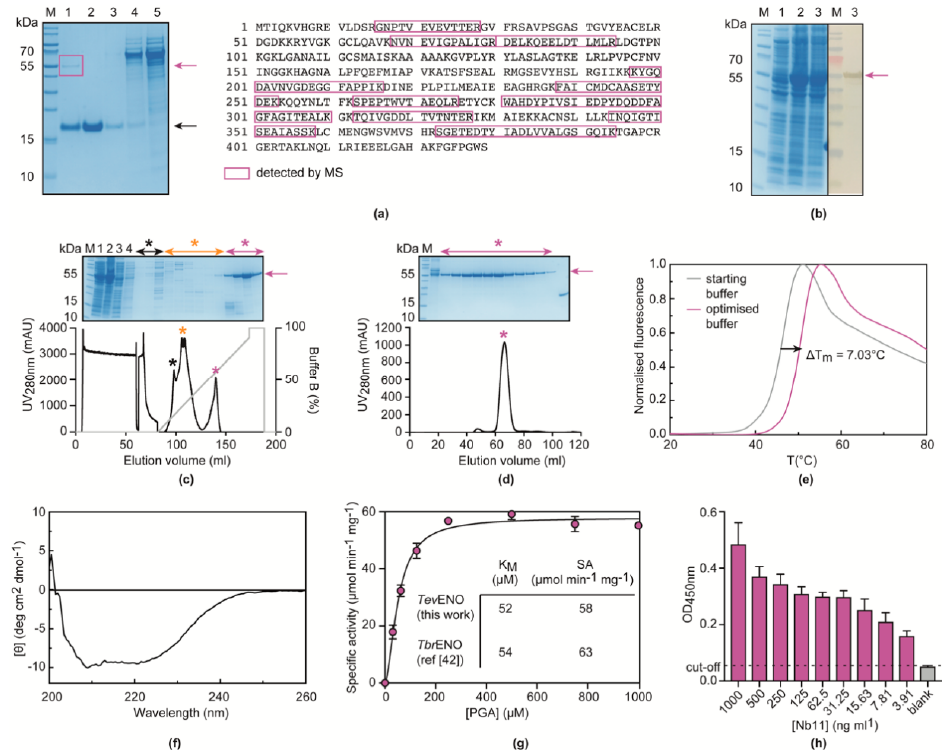
Figure 3. Nb11-mediated identification of T. evansi enolase ( Tev ENO) as the target antigen. ( a ) Nb11- mediated immunocapturing experiment and MS analysis. T. evansi secretome was allowed to interact with nickel beads loaded with His-tagged Nb11. After a washing step, the captured protein was eluted, and all fractions were analyzed on a 12% SDS-PAGE developed with Coomassie blue stain. Lane M, PageRuler Prestained Protein Ladder; Lane 1, eluted fraction; Lane 2, Nb11; Lane 3, wash fraction; Lane 4, secretome flow through; Lane 5, T. evansi secretome (starting material). Native Tev ENO and Nb11 migrate at ≈ 55 and ≈ 15 kDa and are indicated by purple and black arrows, respectively. The boxed gel band was excised and sent for mass spectrometry (MS) analysis, which detected several peptides (highlighted by purple boxes) covering up to 39.86% of the entire Tev ENO sequence. ( b ) Recombinant production of Tev ENO in Escherichia coli . Samples of the bacterial culture were taken before induction (Lane 1), 4 h after induction (Lane 2), and 16 h after induction (Lane 3) and analyzed by SDS-PAGE (left) and Western blot (right). The band corresponding to His-tagged Tev ENO is indicated by the purple arrow. Lane M, PageRuler Prestained Protein Ladder. ( c , d ) Purification of recombinantly produced Tev ENO via immobilized ion metal affinity chromatography (IMAC) ( c ) and size exclusion chromatography (SEC) ( d ). The insets represent SDS-PAGE analyses of the purification procedure. Lane M, PageRuler Prestained Protein Ladder; Lane 1, supernatant of the bacterial culture after sonication; Lane 2, pellet after sonication; Lane 3, IMAC flow through; Lane 4, IMAC wash; Lanes ‘*’, various fractions collected during IMAC elution and SEC. ( e ) Results of the TSA conducted with Tev ENO in an effort to improve its stability during purification. The grey and purple traces represent the Tev ENO melting curves in the starting (50 mM Tris, 200 mM KCl, 5 mM MgCl 2 , pH 8.0) and optimized (50 mM sodium phosphate, 5 mM MgCl 2 , pH 7.0) buffers, respectively. ( f ) CD spectrum of Tev ENO, collected in the optimized purification buffer, shows that the recombinantly obtained enzyme is properly folded. ( g ) Enzymatic activity of recombinantly produced Tev ENO towards different concentration of its substrate 2-phosphoglycerate (2-PGA). The inset shows a comparison of the kinetic parameters obtained for Tev ENO in this work and those determined for Tbr ENO by Hannaert and co-workers [44]. ( h ) Titration curve of Nb11 on Tev ENO via indirect ELISA. The black dashed line refers to the ELISA cut-off (without Tev